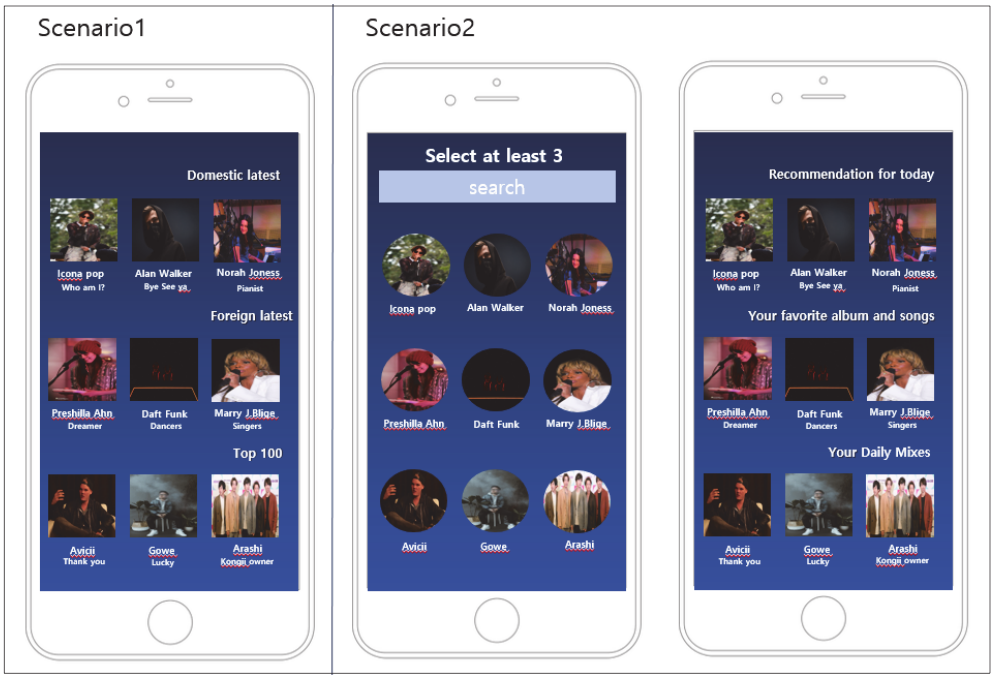
<Figure 7> Embodied app screen images (Scenario1,